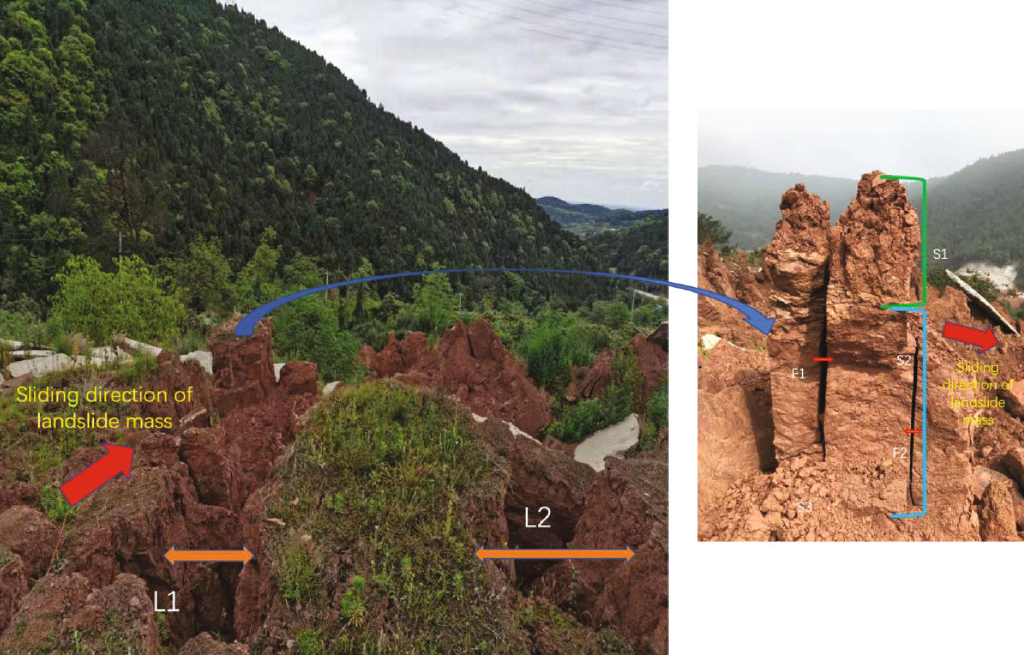
Figure 2: Landslide area surface photographed in di ff erent seasons. The picture on the left was taken on September 1, 2020. The picture on the right was taken on March 2, 2021. L represents the almost north – south fracture, F represents the almost east – west fracture, and S represents weathered red-bed soft rock.